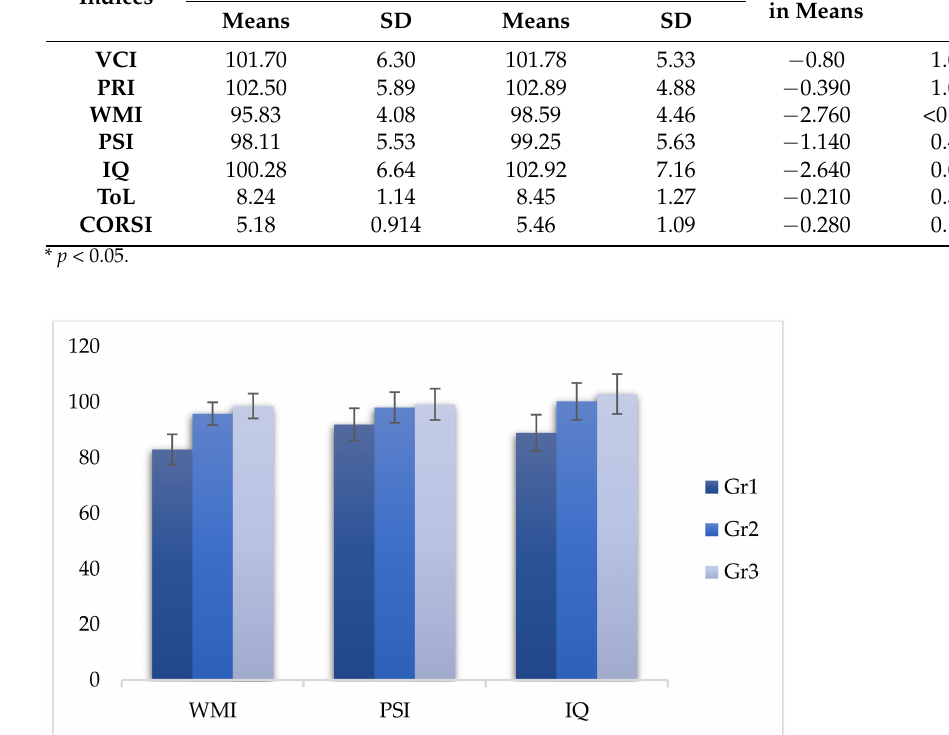
Figure 1. Comparison of WISC-IV (Wechsler Intelligence Scale for Children -IV) indices between the three groups.